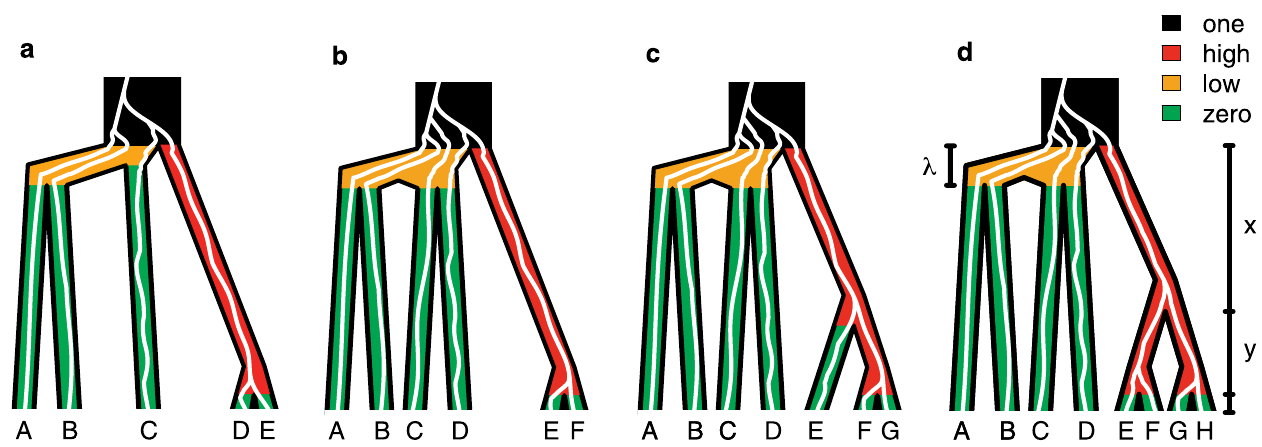
Figure 3. The Production of Anomalies for n -Maximally Probable Species Tree Topologies with n ¼ 5,6,7,8 (See Table 1) The branch lengths x , y , and k apply to each tree: in (a) and (b), x þ y denotes the length of the red internal branch, and in (c) and (d), x and y are the lengths of the deeper and shallower red internal branches, respectively; the length k denotes the branch length between the root of the species tree and the MRCA of species A and B. For each tree, the color of a branch represents the probability that coalescences occur on the branch. On an external branch, because there is only one gene lineage, coalescences cannot occur. Prior to the root, the probability is 1 that all lineages coalesce. During the time between the root of the species tree and the divergence of A and B—and of C and D in (b–d)—the probability that any coalescences occur can be made arbitrarily close to 0 by making the internal branches sufficiently short. Similarly, by choosing x and y to be sufficiently large, the probability that all available lineages coalesce on the red branches can be made arbitrarily close to 1. In (a), the species tree can be represented as (((AB)C)Z), where Z is (DE). By making the internal branch ancestral to D and E long, the subtree Z is similar to a single taxon, and the five-taxon tree behaves like the four- taxon asymmetric tree (((AB)C)Z), which produces the anomaly ((AB)(CZ)). Thus, in (a), the AGT is ((AB)(C(DE))). Similarly, the species tree topologies in (b), (c), and (d) have the form (((AB)(CD))Z) and produce anomalies (((AB)C)(DZ)); in (b), (c), and (d) Z is (EF), (E(FG)), and ((EF)(GH)), respectively. The anomalies occur by letting internal branches in subtrees ((AB)(CD)) and Z be sufficiently short and long, respectively. DOI: